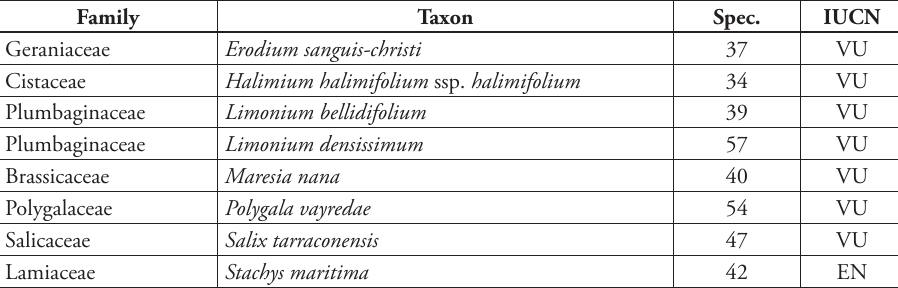
Table 3. Taxa with more than 30